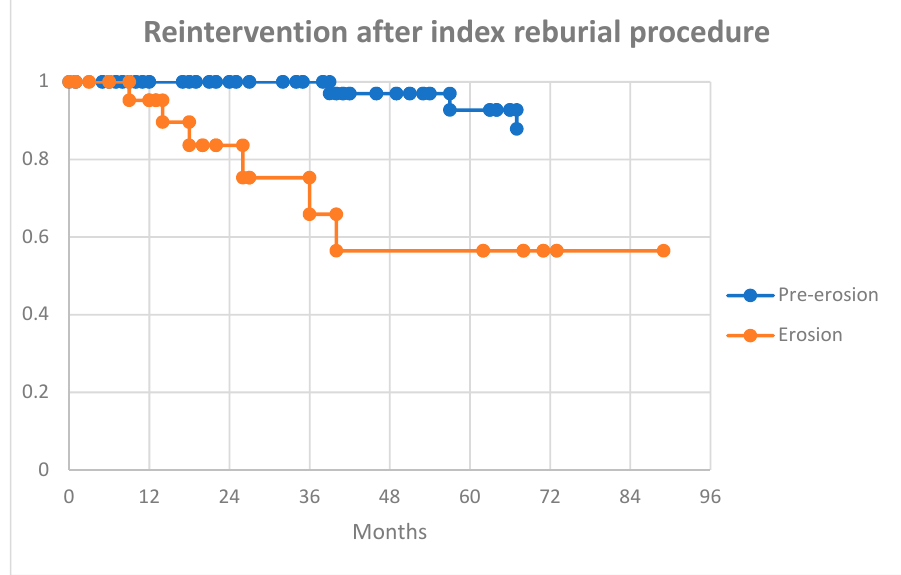
Figure 2. Kaplan–Meier curve showing the need for reintervention after the index reburial procedure.